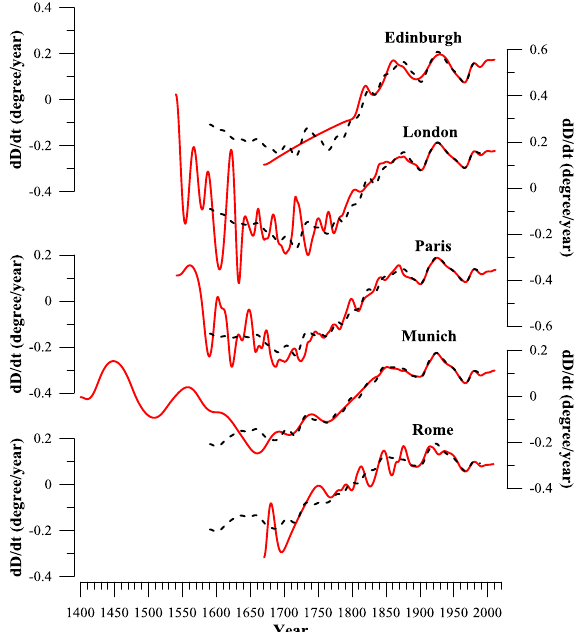
Figure 10. The first time derivative of the sub-centennial constituent at the five locations from the trend of observed data (blue) and of gufm1 (dashed black); a high-pass 73-year cutoff Butterworth filter- ing on the time series in Fig. 9 is